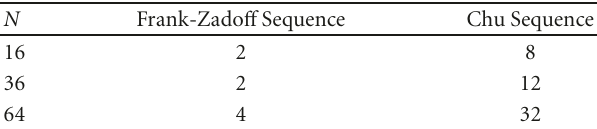
Table 1: Number of possible Frank-Zado ff and Chu sequences for di ff erent sequence